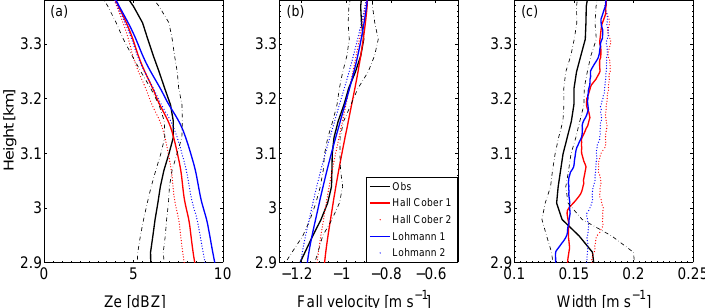
Figure 11. A comparison of observed and modeled moments of the frontal snow mode in the SLW layer. Black solid and dashed lines refer to the mean and standard deviation of the slanted paths encompassed by the two black fall streaks in Fig. 5. Model results based on riming efficiencies by Hall & Cober as well as Lohmann are shown in red and blue, respectively (see text for details). Model results assuming area ratio increase with mass and rimed fraction (solid red and blue line) as well as with mass only (dotted red and blue) are